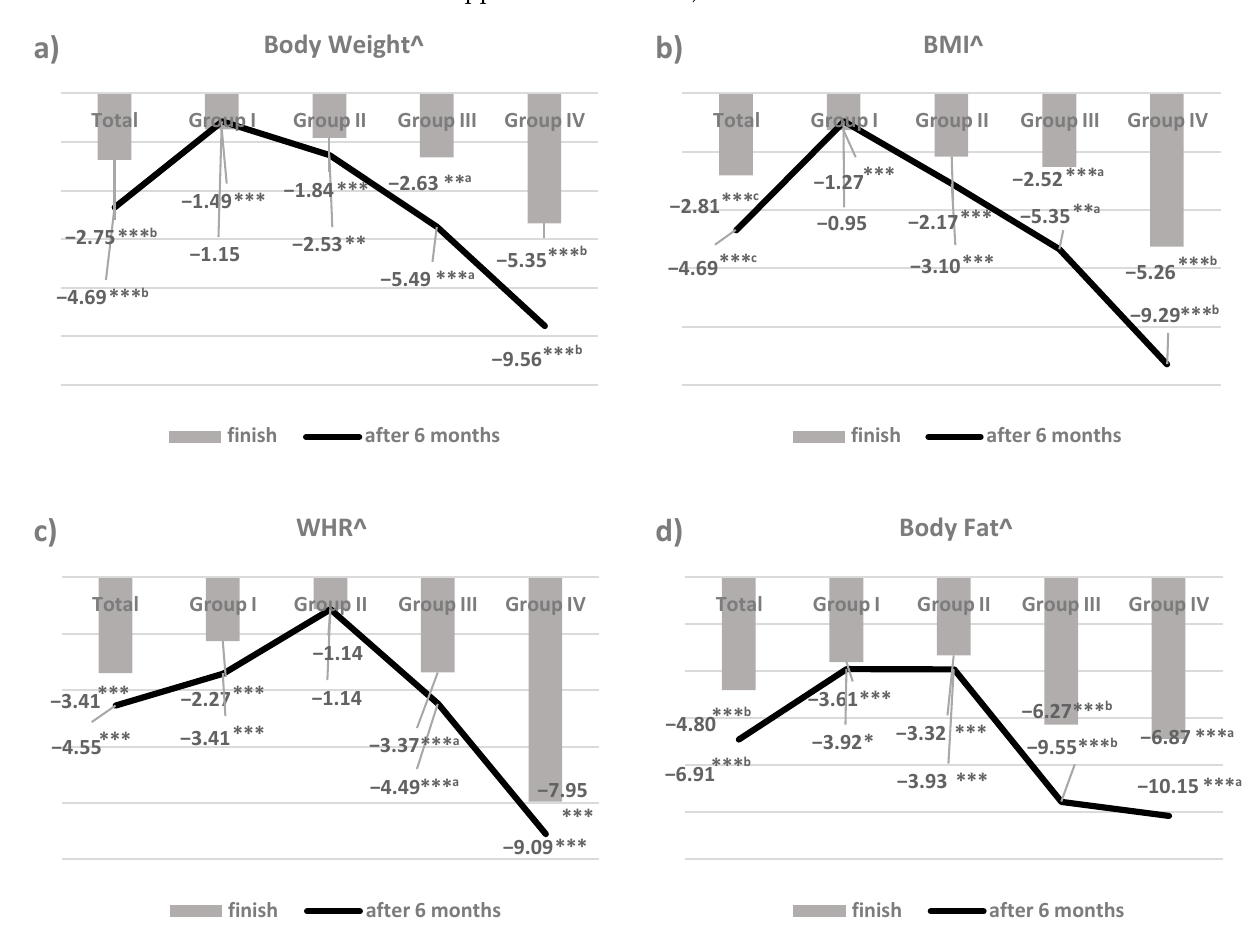
Figure 1. The effect of therapeutic management on selected anthropometric parameters (( a ) Body Weight; ( b ) BMI; ( c ) WHR; ( d ) Body Fat) of the study women (percentage differences with respect to the baseline results); ˆstatistical analysis of the differences between the results six weeks (end of the study) and six months after the experiment in relation to the start of the study (at * p < 0.05; ** p < 0.01; *** p < 0.001) and between the end of the research and the period six months after its completion (at a-a p < 0.05; b-b p < 0.01; c-c p < 0.001).